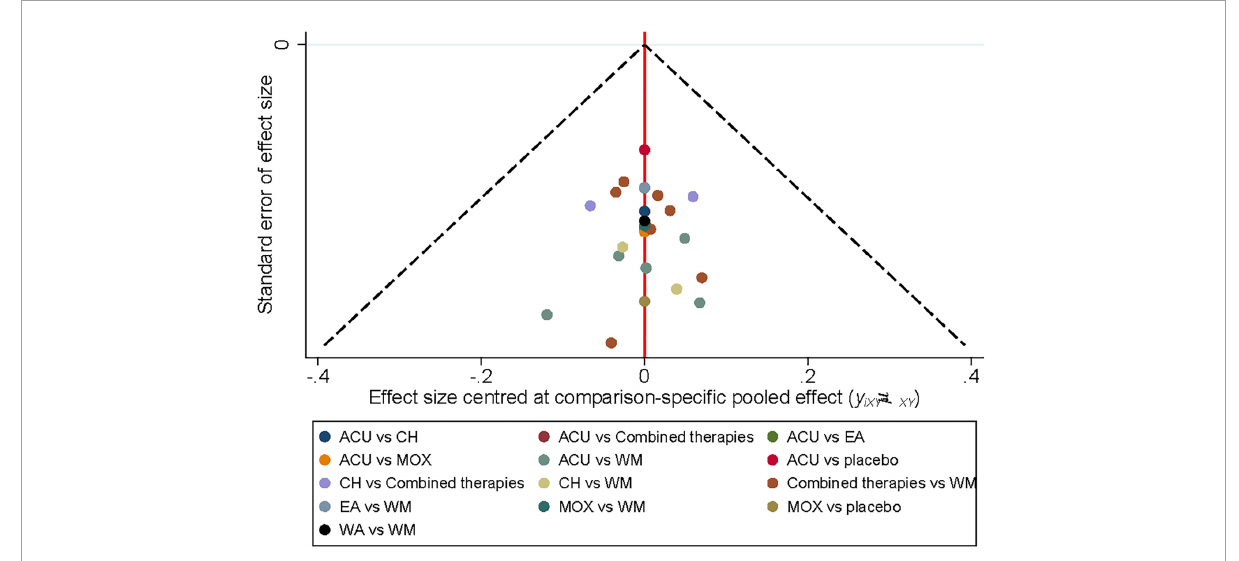
FIGURE6 Funnel diagram. ACU, acupuncture; EA, electroacupuncture; MOX, moxibustion; CH, Chinese herb medicine; WA, warm acupuncture; combined therapies, the combination of acupuncture-related therapies and other therapies; WM, western medicine of anti-diarrheal or anti-spasmodic; placebo, and placebo acupuncture/blank